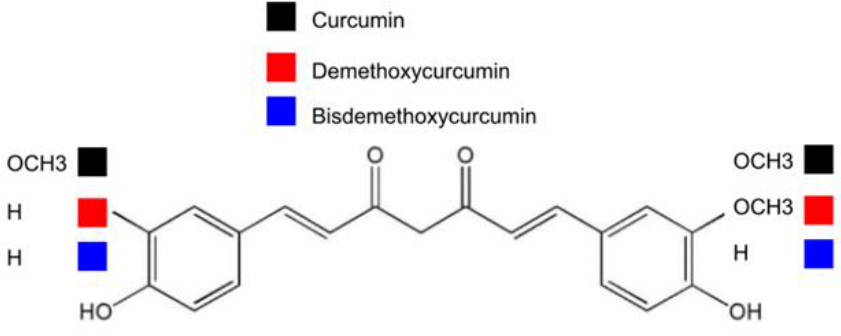
Figure 3. Chemical structure of curcuminoids: curcumin, demethoxycurcumin, and bisdemethoxy-